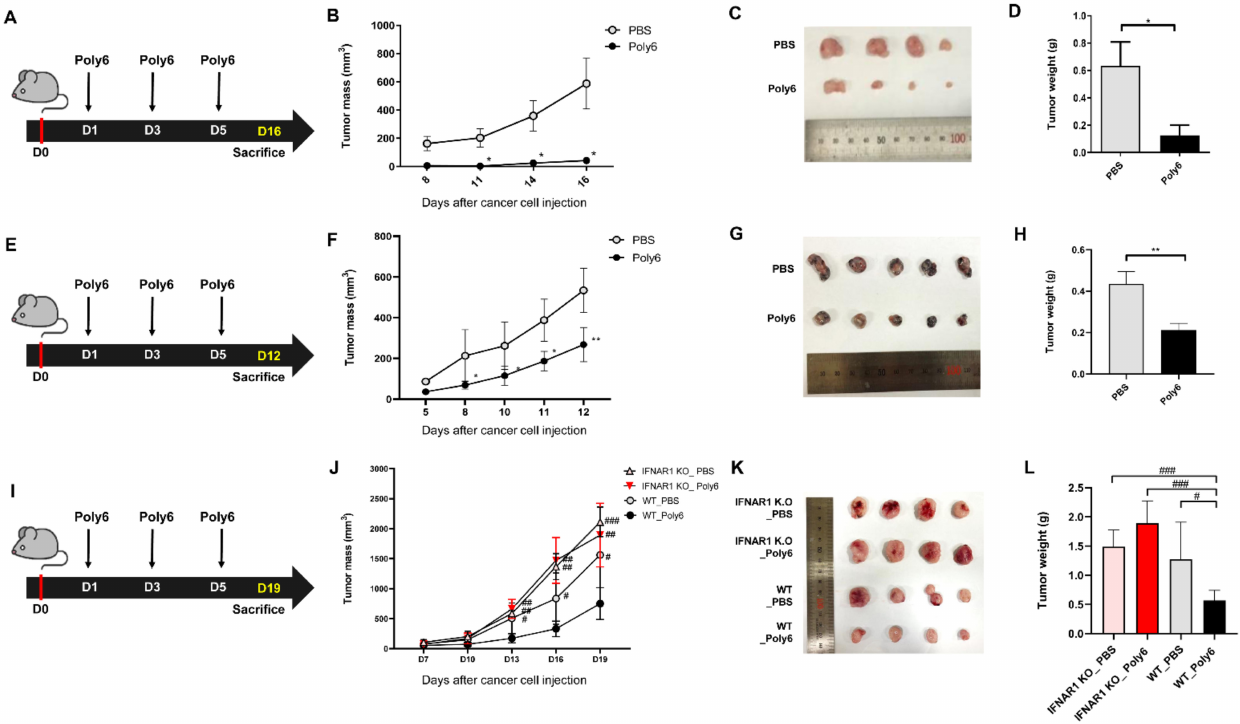
Figure 2. Poly6 exerts anticancer effects in cancer-bearing mouse models. ( A ) Schematic in vivo experimental schedule performed post treatment with Poly6 to verify its therapeutic anticancer effect. MC38 cells (1 × 10 6 ) were inoculated by subcutaneous route into C57BL/6 mice ( n = 4). ( B ) Observing attenuated tumor progression by assessing MC38 tumor growth. ( C ) Images of tumors extracted from MC38 tumor-bearing mice on day 16. ( D ) MC38 colon tumor weight was calculated. ( E ) In vivo experimental schedule of melanoma cancer. B16F10 cells (1 × 10 6 ) were subcutaneously